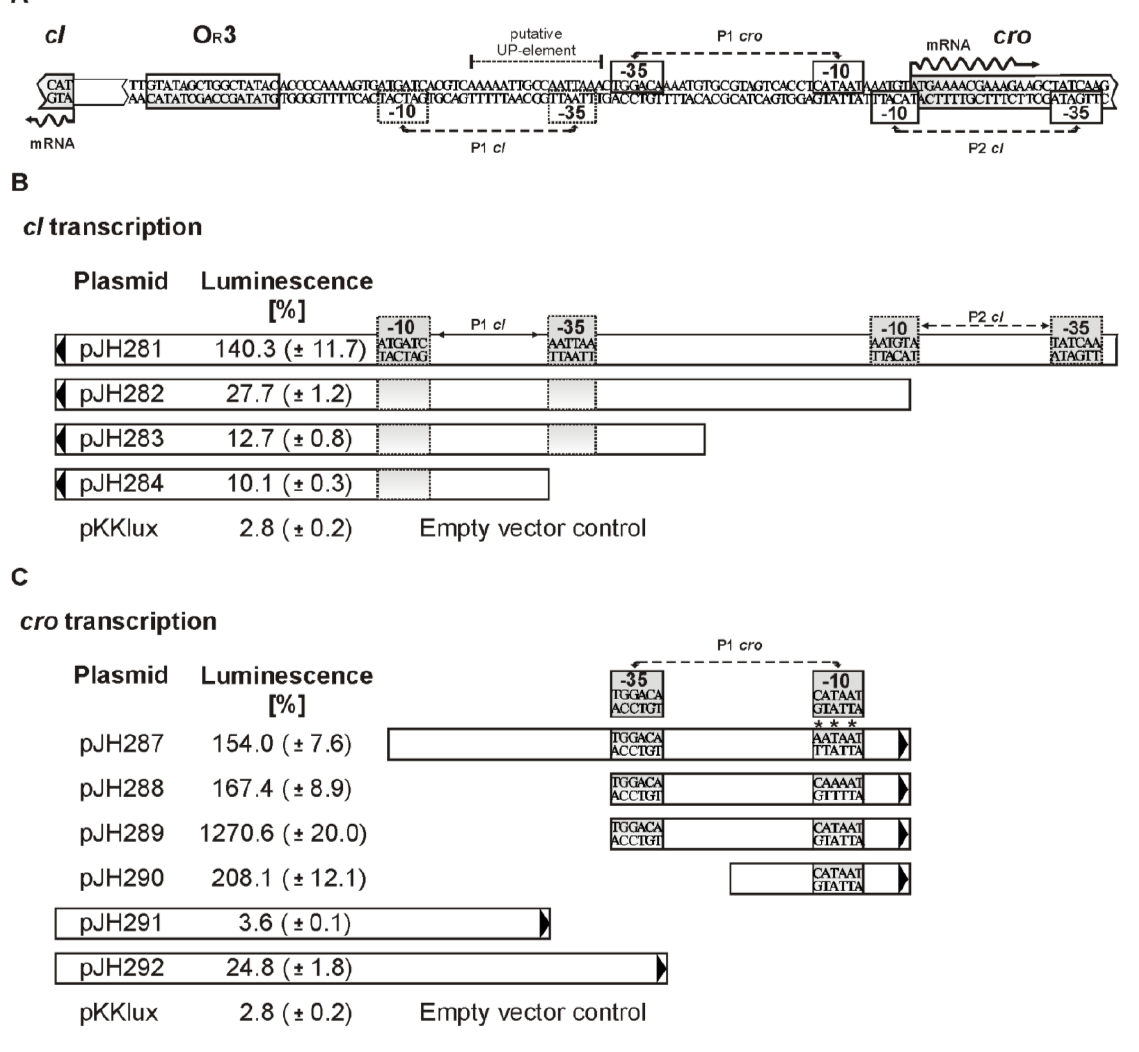
Figure 6. Identification of functional cI and cro promoters in PY54. ( A ) Sequence of the DNA region between the repressor genes cI and cro . The Cro binding site and promoter sequences identified by luciferase assays are boxed; ( B ) DNA fragments analyzed for cI promoter activity. Arrows indicate the direction in which the fragments were inserted into the promoter search vector pKKlux (Table S1). Transcription activities (bioluminescence) of the constructs compared to those of pKKL700 (ST-LS1 promoter = 100%) are given. Standard deviations are shown in brackets; ( C ) Constructs tested for cro promoter activity. Mutations found within the −10 region [CATAAT] are depicted by asterisks. The encircled nucleotide A in pJH287 and pJH288 indicates the replacement of the nucleotides C and T, respectively.